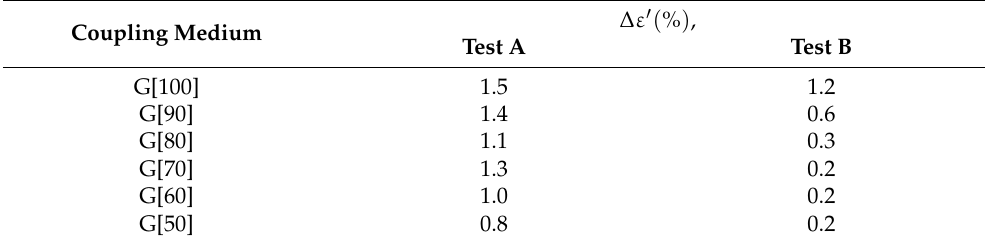
Table 2. Average percentage variation of the relative permittivity, ∆ ε (cid:48) ( % ) ,, Estimated with: Test A—amount of coupling medium applied on the tooth surface; Test B—time elapsed between the application of the coupling medium on the tooth surface and the beginning of the measurement.